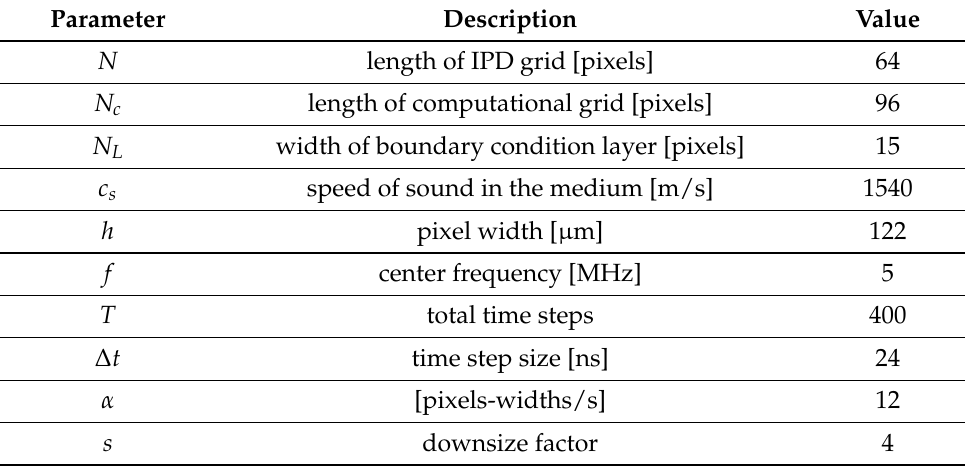
Table 1. The parameters used in our simulations and their associated